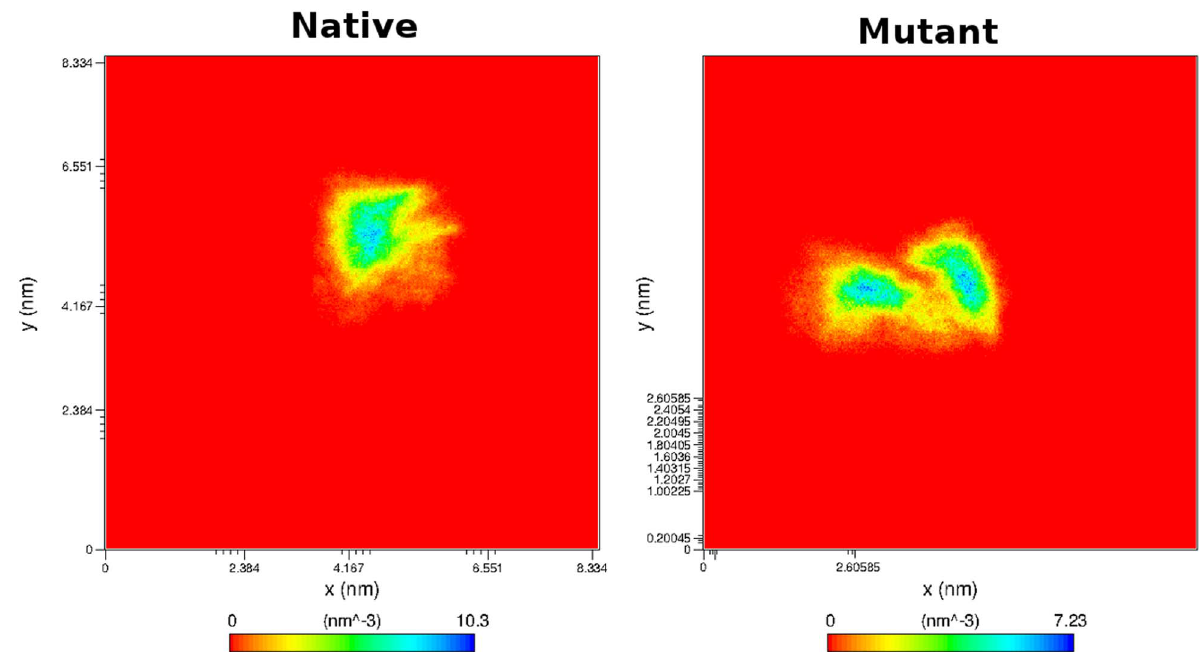
PLOS Computational Biology |